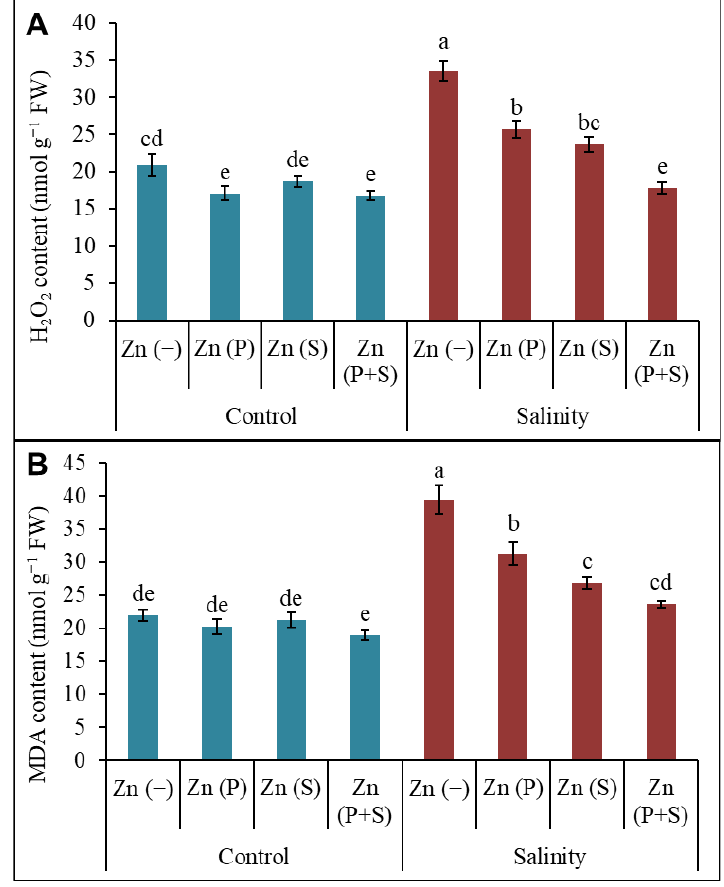
Figure 4. Content of H 2 O 2 ( A ) and MDA ( B ) of soybean plants induced by Zn supplementation. Twenty five-day-old plants were subjected to salt (150 mM NaCl) and supplemented with Zn (1 mM ZnSO 4 · 7H 2 O). P and S indicate seed priming and foliar application with Zn, respectively. Control treatments were grown with water. Mean ( ± SD) was calculated from three replicates for each treatment. Different letters of bars indicate significant differences at p ≤ 0.05 applying Tukey’s HSD test.